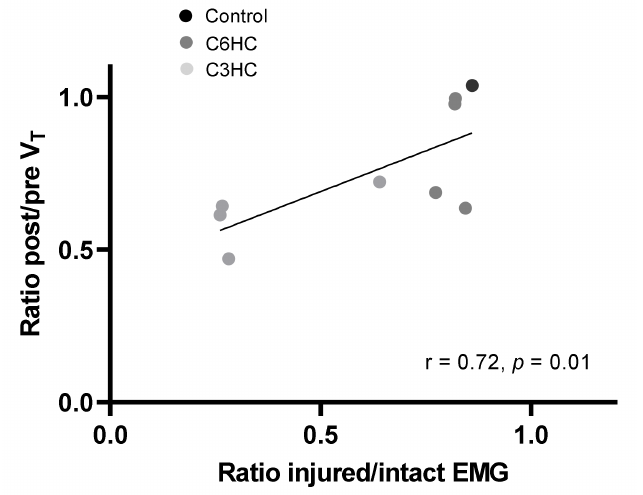
Figure 5. Relationship between changes in respiratory function and diaphragmatic activity. Sim- ple linear relationship between diaphragmatic EMG activity of the injured side and that of the intact side (injured-to-intact ratio) and changes in tidal volume (ratio of post/pre values) 7 days post-lesion in animals after performing both plethysmography and EMG recordings (Pearson correlation